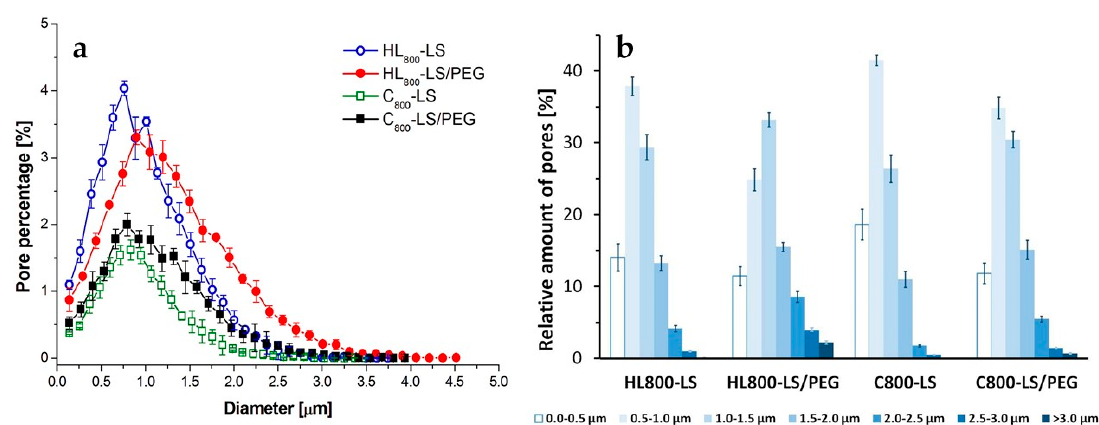
6 of 14 Figure 2. Scanning electron microscope (SEM) images of ( a ) hydraulic lime-based mortar without phase change material (PCM) (HL 800_ LS (Lecce stone)); ( b ) hydraulic lime-based mortar with PCM (HL 800_ LS/PEG (poly(ethylene glycol))); ( c ) cement-based mortar without PCM (C 800_ LS) and ( d ) cement-based mortar with PCM (C 800_ LS/PEG). The absence of voids and cracks in the microstructure of the developed mortars, irrespective to their composition, suggests a good connection between the different components (LS or LS/PEG and each binder). Differences in the pore size and pore distribution were found when comparing the mortars with and without PCM, as can be observed from the results in Figure 3. A slight increase in the total pores was measured when the PCM was added to each mortar (Table 2). Taking into account that the total pores account for the porosity of the material, the mortars based on hydraulic lime were generally more porous than the cement-based ones, as expected. The most frequent pore size was